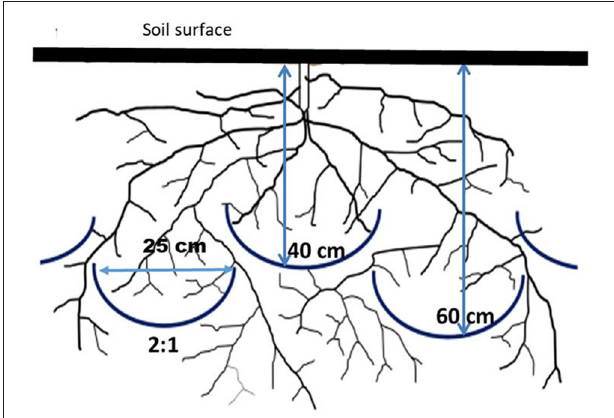
FIGURE 2 | Location and aspect ratio of U-shaped sub-surface water retention technology (SWRT) membranes (25cm wide) installed in the root zone of on-farm SWRT